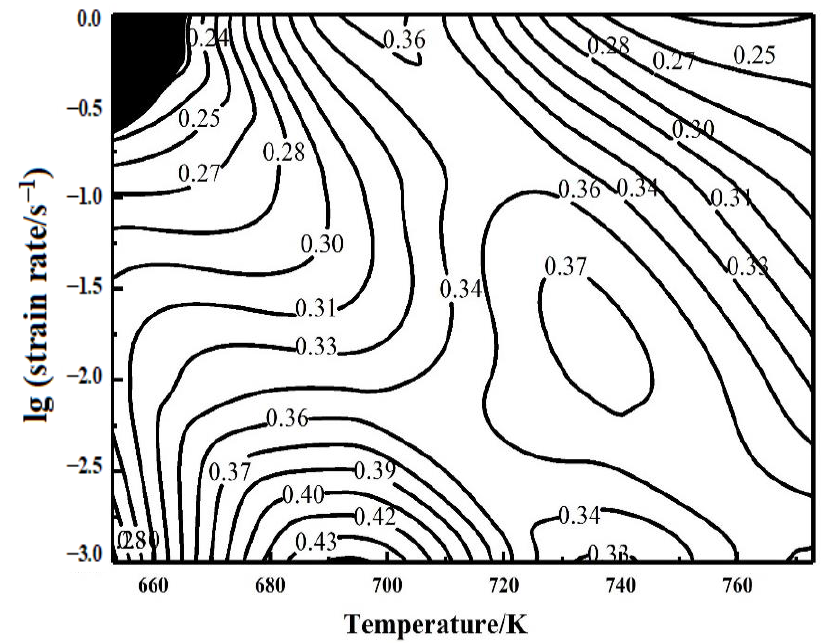
Figure 5. Processing map of the alloy.